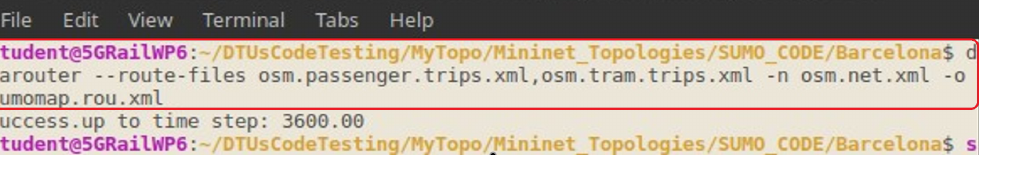
Figure 45. Change IDs of vehicles.